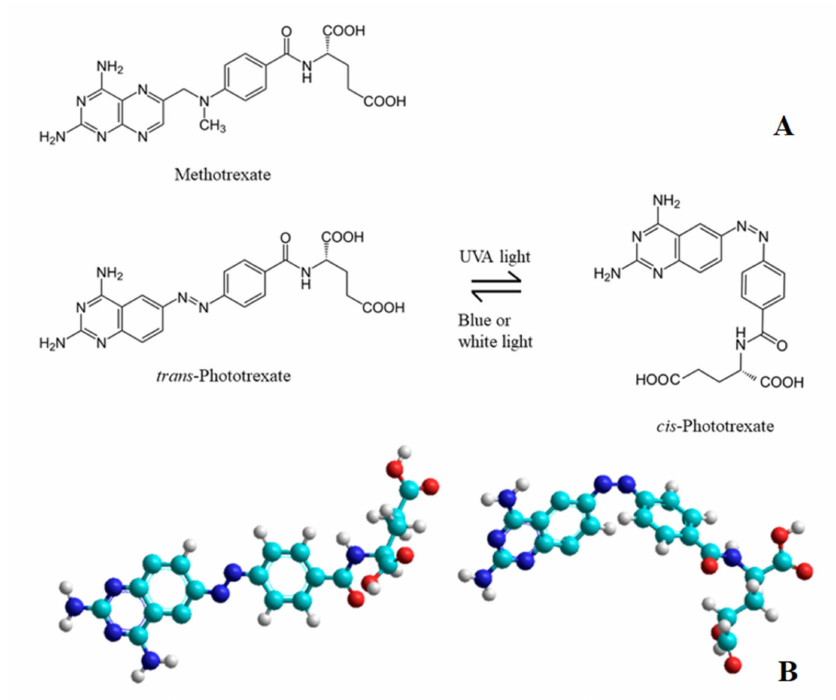
Figure 1. ( A ) Chemical structures of Methotrexate (MTX), trans -Phototrexate ( trans -PHX) and cis - Phototrexate ( cis -PHX) and the reversible isomerization of PHX [11]. ( B ) The 3D structure of the two isomers of the PHX: trans -PHX ( left ) and cis -PHX ( right